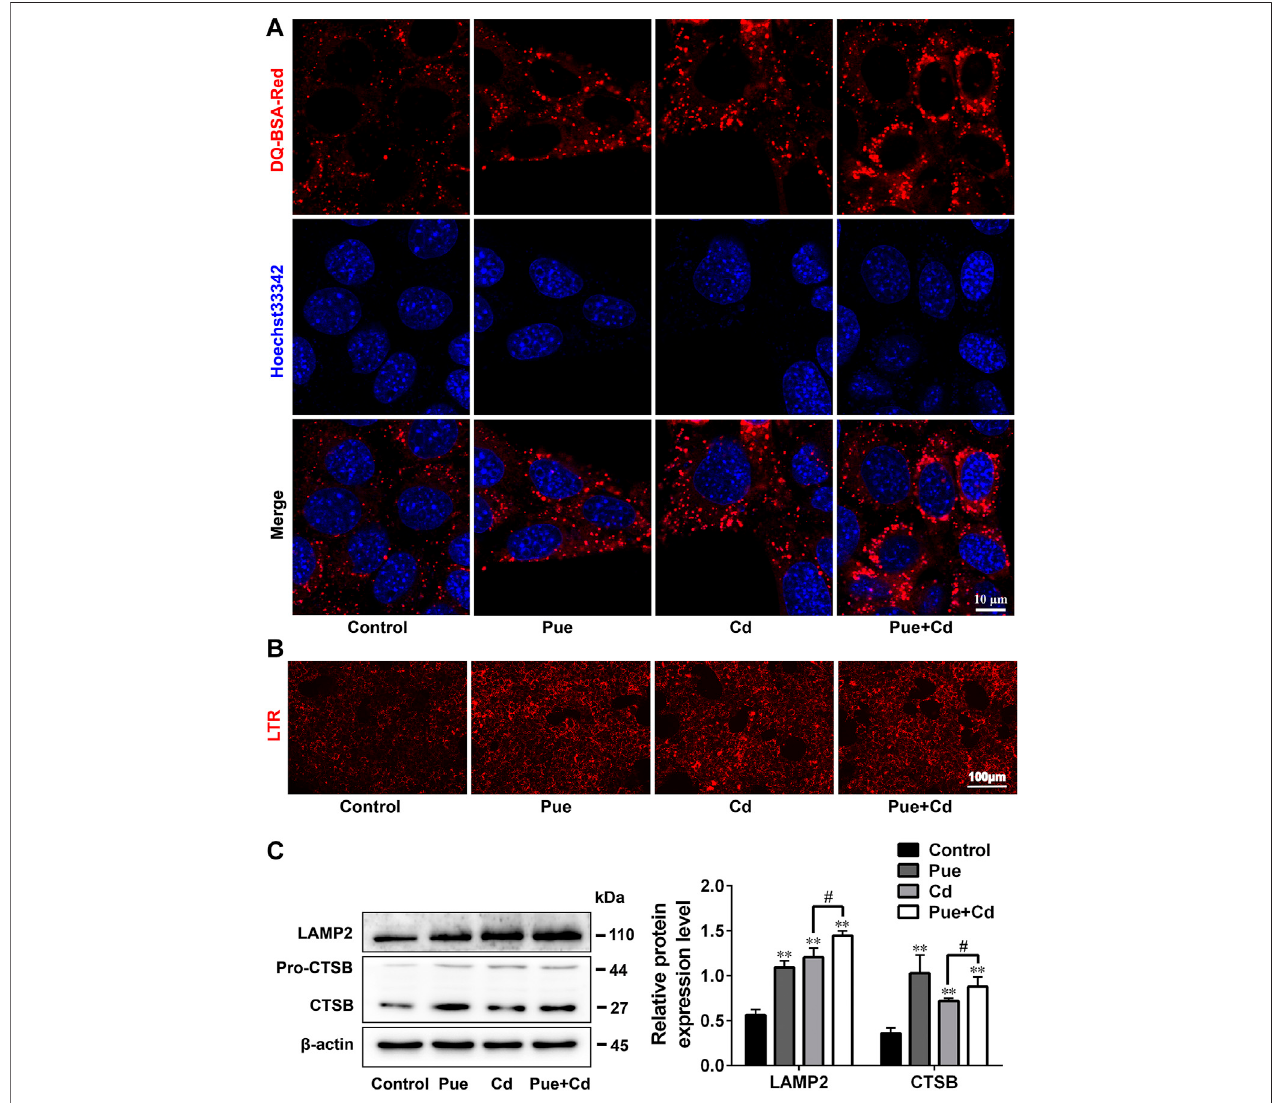
FIGURE4| PueandCdpromotedlysosomaldegradationbytriggeringlysosomalactivationinAML12cells. (A) TheeffectofPueandCdonlysosomaldegradation in AML12 cells was analyzed using DQ-BSA-Red staining. Representative fl uorescence images are shown, and the red fl uorescence indicates the fl uorescent fragment released after DQ-BSA was degraded by the lysosome. Scale bar (cid:2) 10 μ m. (B) The effect of Cd and Pue in combination on the lysosomal acidity in AML12 cells was re fl ected by LTR staining. Scale bar (cid:2) 100 μ m. (C) Cells were treated with Pue and Cd, alone or in combination, for 12 h, and then the levels of LAMP2 and CTSB wereexaminedusing westernblotting.Dataareshown asthemean ± SD (n (cid:2) 3). Comparedwith thecontrolgroup, ** p < 0.01. Compared withthe Cdgroup, # p < 0.05.